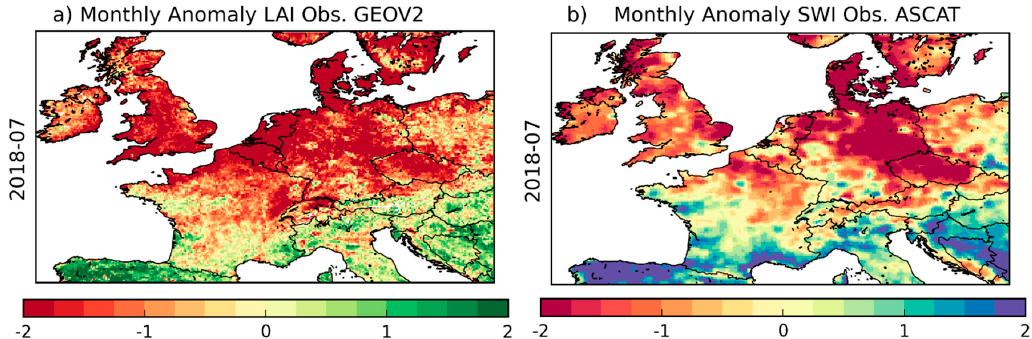
Figure 1. Monthly Anomaly time-series (scaled by the standard deviation) of satellite derived ( a ) GEOV2 Leaf Area Index over 2000–2018 and ( b ) Surface Soil Moisture over 2008–2018 from the Copernicus Global Land Service averaged over the domain (presented by Figure 2). Months of July are highlighted in red, straight dashed lines represent values for July 2018.